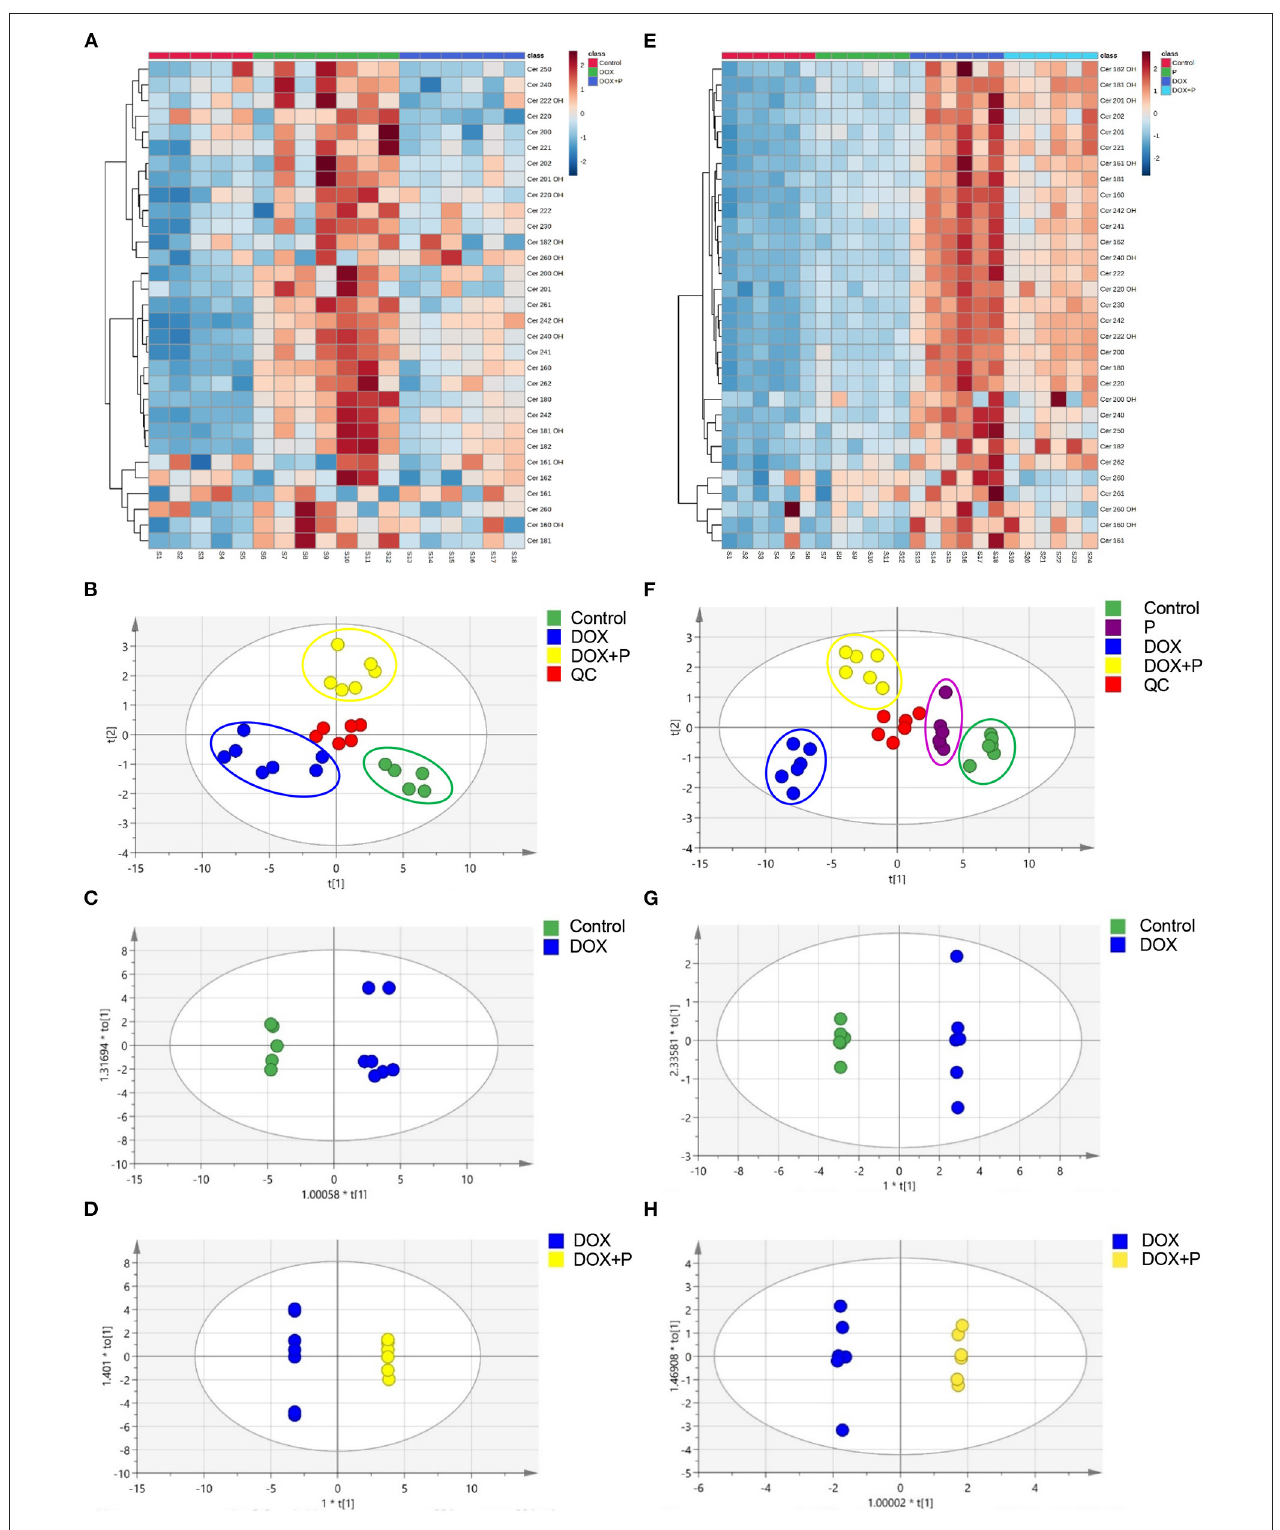
FIGURE 3 | Periplocymarin regulated metabolic disorders induced by DOX. (A–D) . The ceramides in mice serum were measured by liquid chromatography with tandem mass spectrometry (LC-MS/MS). The cluster heatmap of ceramides was presented (A) . The score scatter plots of the quality control (QC) and the mice